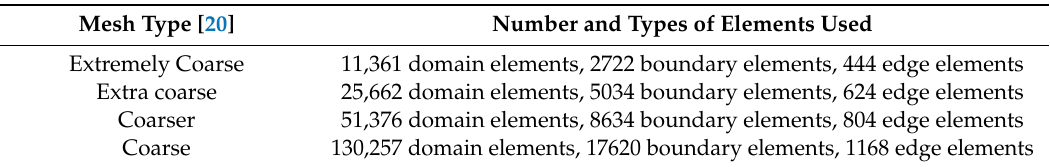
Table 2. Mesh information for di ff erent level of meshing.